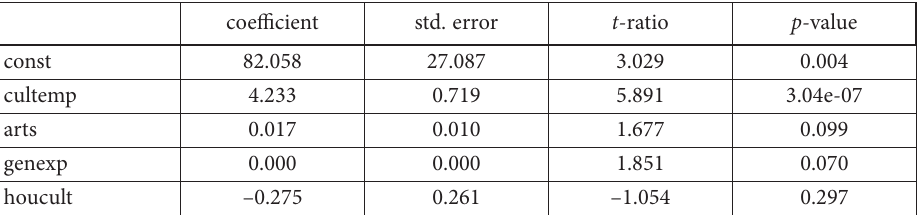
Table 9. 2018–2020 panel regression analysis (source: compiled by the author)